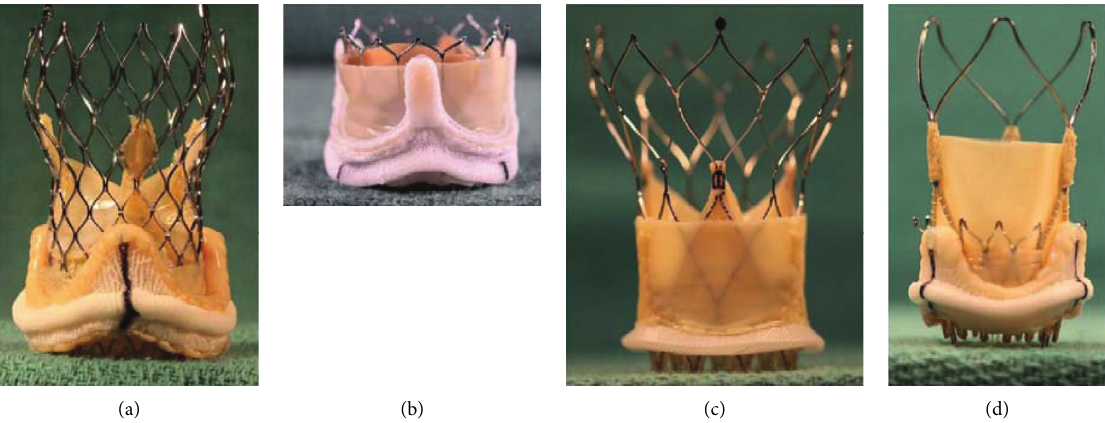
Figure 2: Ex vivo examples of THVs mounted in surgical bioprostheses. (a) Evolut R 23mm THV in an Epic 21mm surgical valve. (b) Sapien 23mm THV mounted in a Perimount Magna Ease 21mm surgical valve. (c) Portico 23mm THV mounted in a Trifecta 21mm valve with externally mounted leaflets. (d) ACURATE neo S mounted in Epic 25mm. Images were obtained from the valve-in-valve aortic app (by UBQO and Dr. Vinayak Bapat), reproduced with permission.